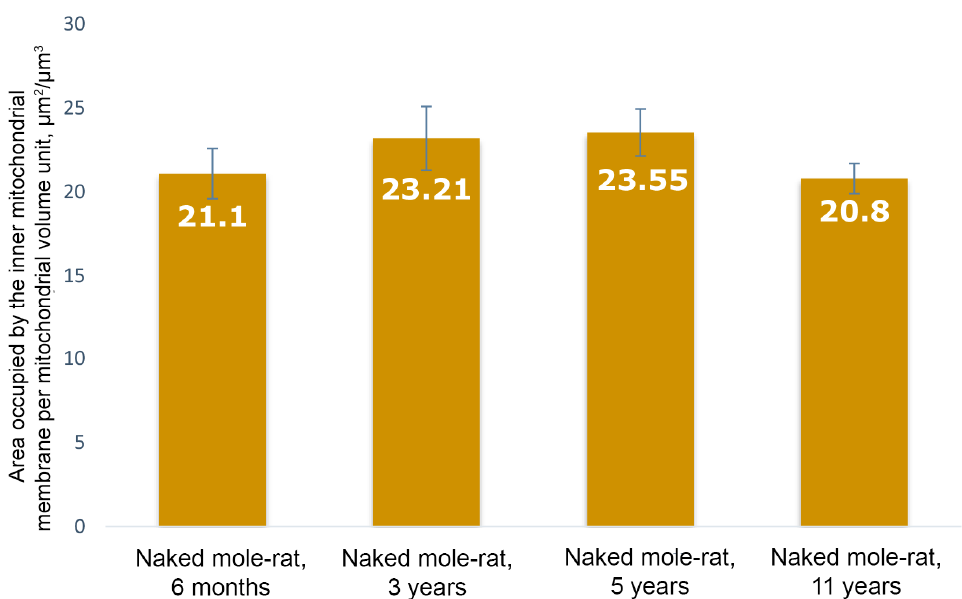
Figure 3. Results of morphometric analysis of cardiomyocyte mitochondria ultrastructure in naked mole rats. The area of inner membrane per mitochondrial volume unit in naked mole rats aged 6 months, 3 years, 5 years, and 11 years.